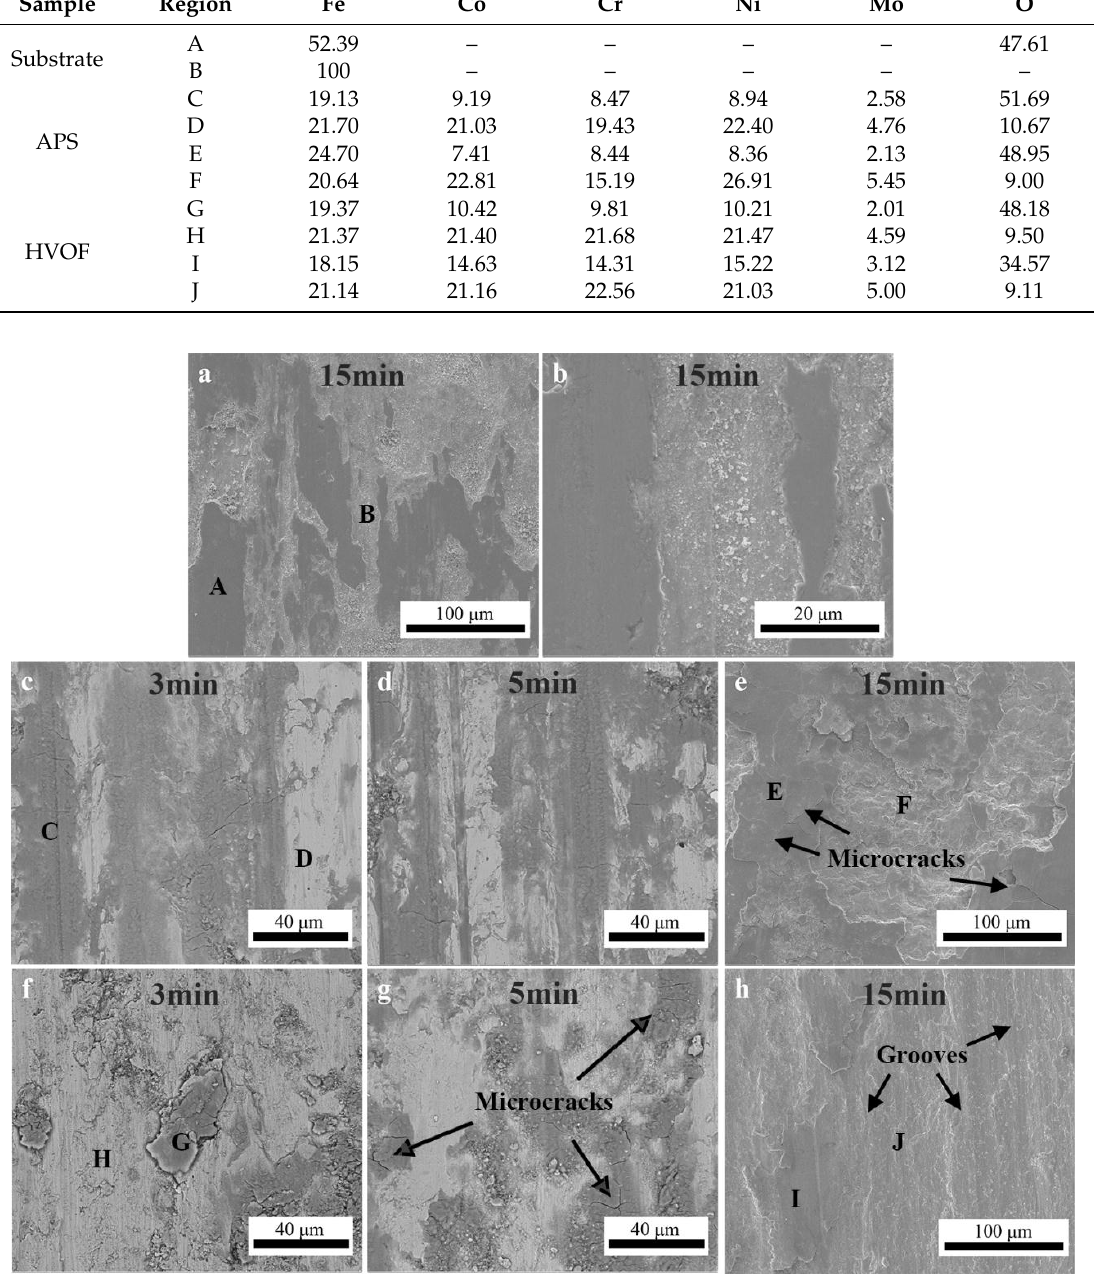
Figure 10. Worn surface morphologies of the HEA coatings and substrate after friction test under different duration: ( a – b ) 45# steel substrate; ( c – e ) the APS coating; and ( f – h ) the HVOF coating.